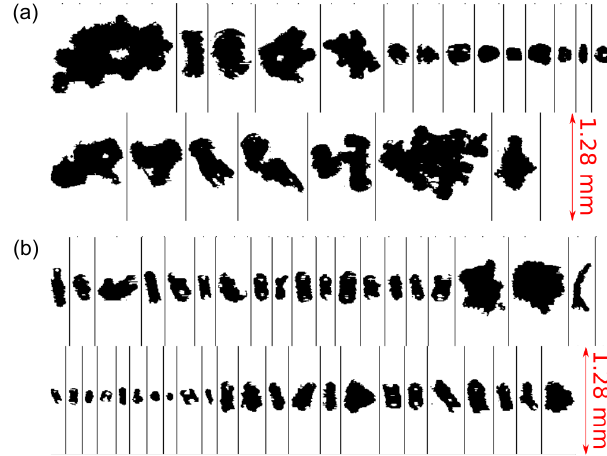
Figure 13. Ice particle images captured by 2D-S probe during the Darwin Campaign. (a) Stratiform cloud region, MMD ≈ 150µm, IWC ≈ 1.2gm − 3 , T ∞ ≈− 10 ◦ C. (b) Convective cloud region, MMD ≈ 80µm, IWC ≈ 3gm − 3 and T ∞ ≈− 10 ◦ C.